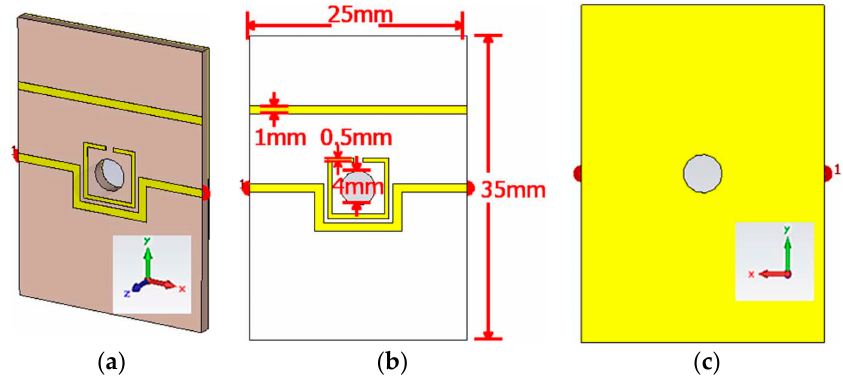
Figure 5. Metamaterial Based Microfluidic Sensor Design consists of a microstrip-coupled square shape ring resonator with one opening gap. A Microfluidic channel is positioned in the middle of the split ring resonator for a strong interaction of electric field with target analyte: ( a ) top view; ( b ) design dimensions; and ( c ) back view (redrawn from [38]).